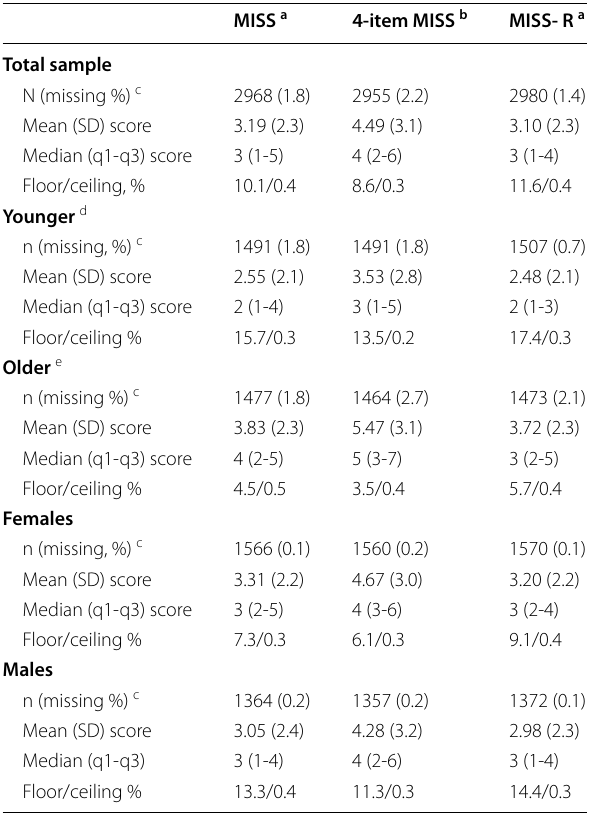
Table 1 Raw score distribution and floor‑/ceiling effects for the MISS; the four‑item MISS; and the MISS‑R